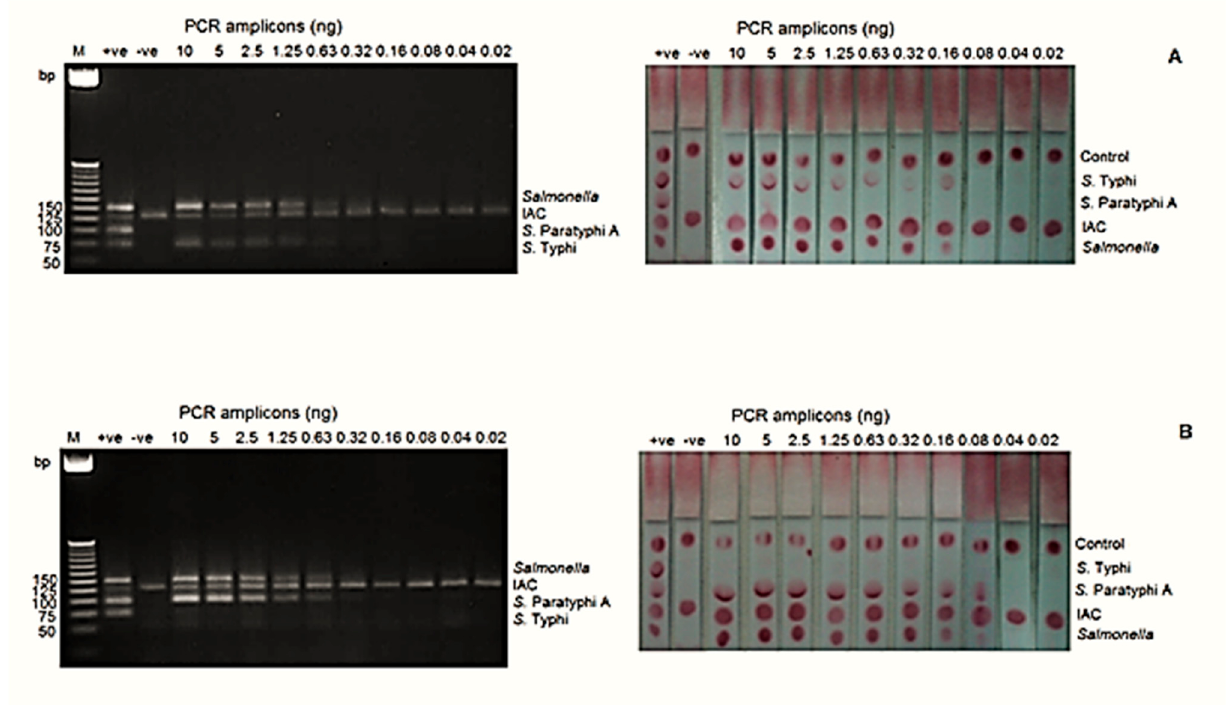
Figure 2. The analytical sensitivity of the mPCR-LFB and mPCR-AGE was determined using different concentrations of PCR amplicons ranging from 0.02 to 10 ng. ( A ) The analytical sensitivity using genomic DNA of S. Typhi was 0.63 ng using mPCR-AGE and 0.16 ng using the mPCR-LFB. ( B ) The analytical sensitivity using genomic DNA of S. Paratyphi A was 0.63 ng using mPCR-AGE and 0.08 ng using the mPCR-LFB. M= 25 bp markers, +ve= positive control, − ve= negative control.